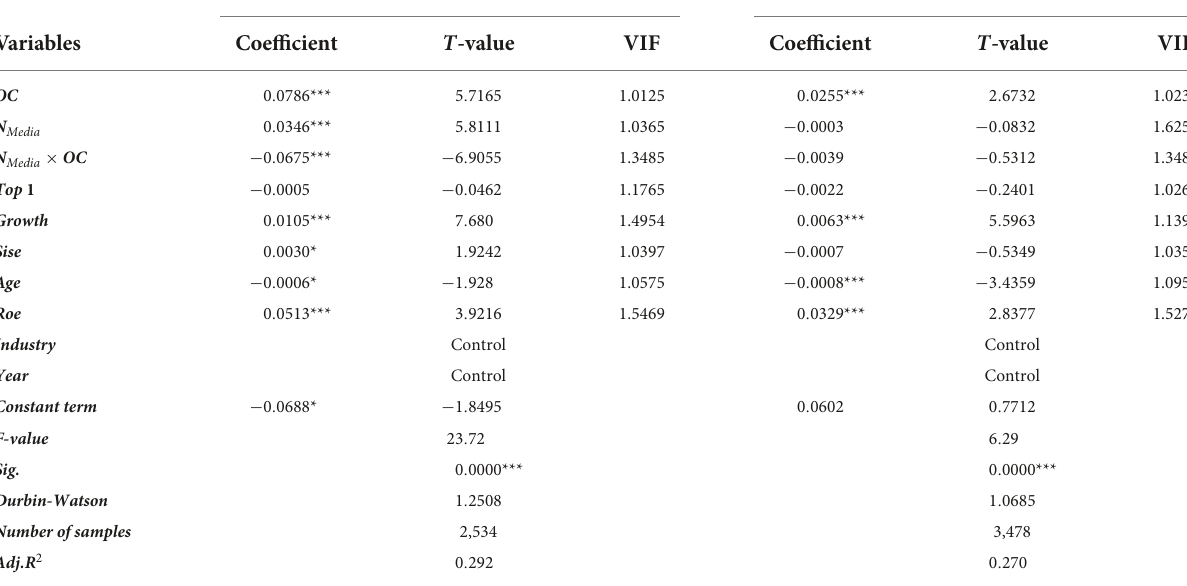
TABLE 7 Regression results of negative media reports under different marketization processes.